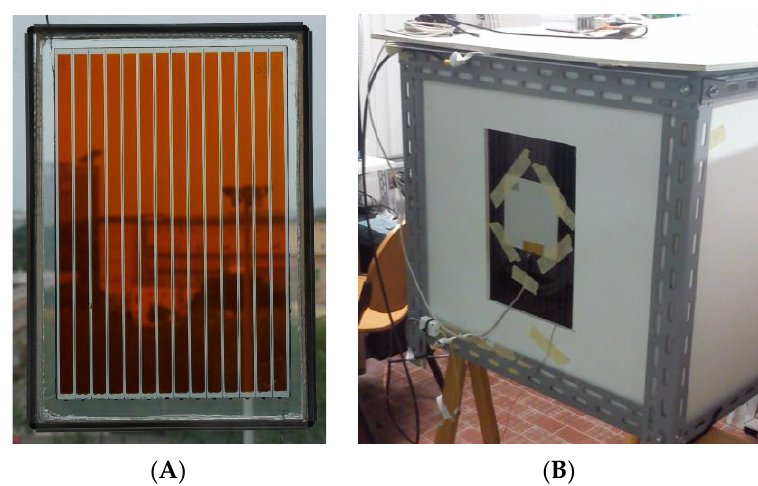
Figure 5. The two boxes used for the STB method.